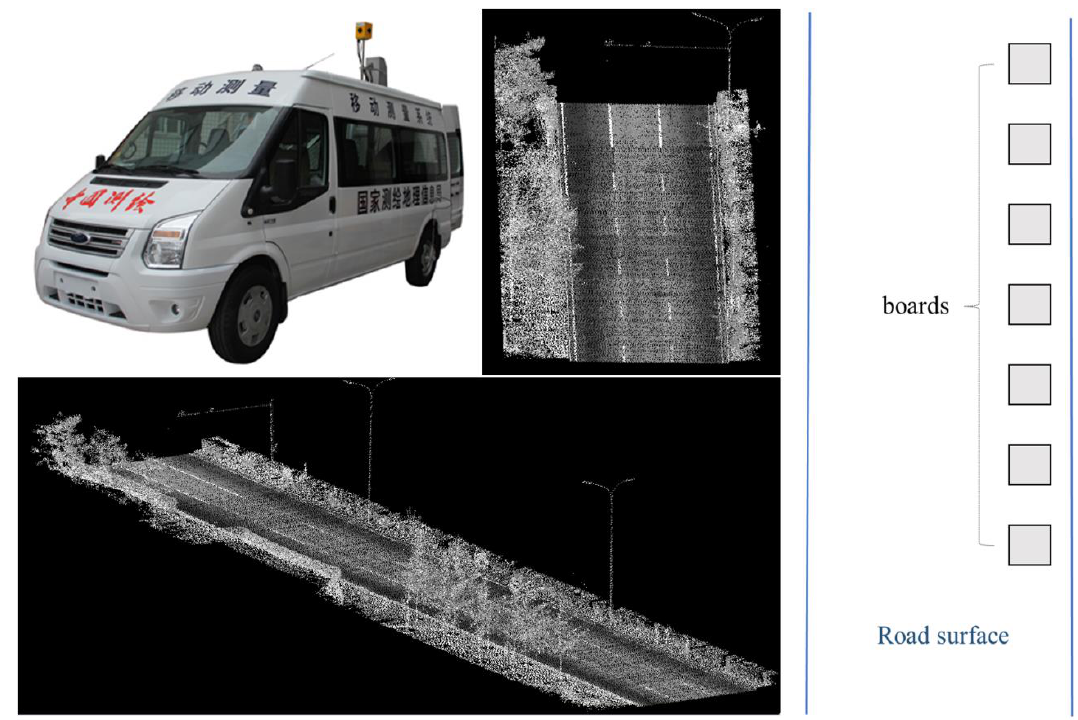
Figure 11. The real experimental data and acquisition system.